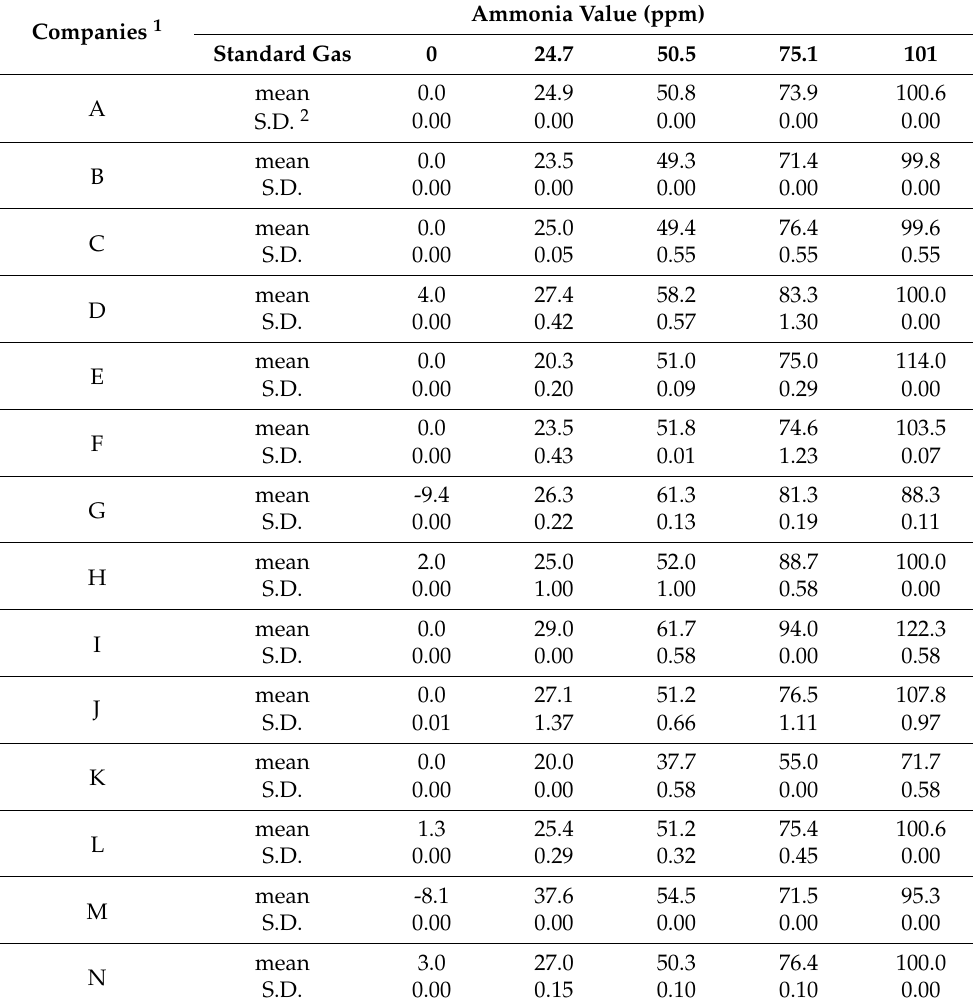
Table 1. Accuracy measurement results of ammonia